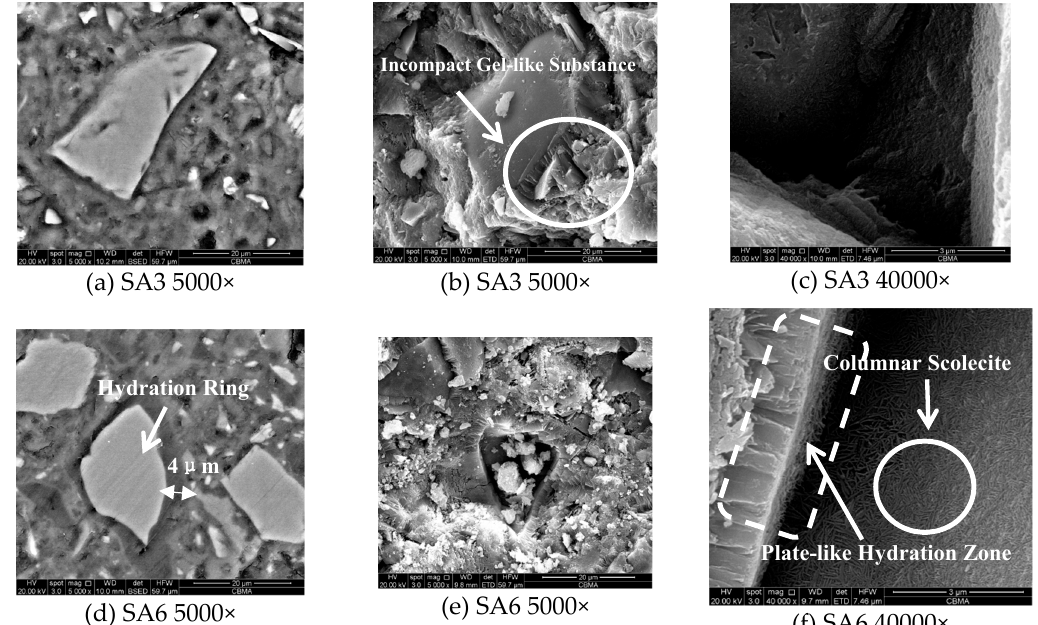
Figure 10. Micro-morphology of slag with di ff erent S / A in the paste at 28 days of hydration: ( a ) SA3 Figure 10. Micro ‐ morphology of slag with different S/A in the paste at 28 days of hydration: ( a ) SA3 5000 × ; ( b ) SA3 5000 × ; ( c ) SA3 40000 × ; ( d ) SA6 5000 × ; ( e ) SA6 5000 × ; ( f ) SA6 40000 × 5000×; ( b ) SA3 5000×; ( c ) SA3 40000×; ( d ) SA6 5000×; ( e ) SA6 5000×; ( f ) SA6 40000×.